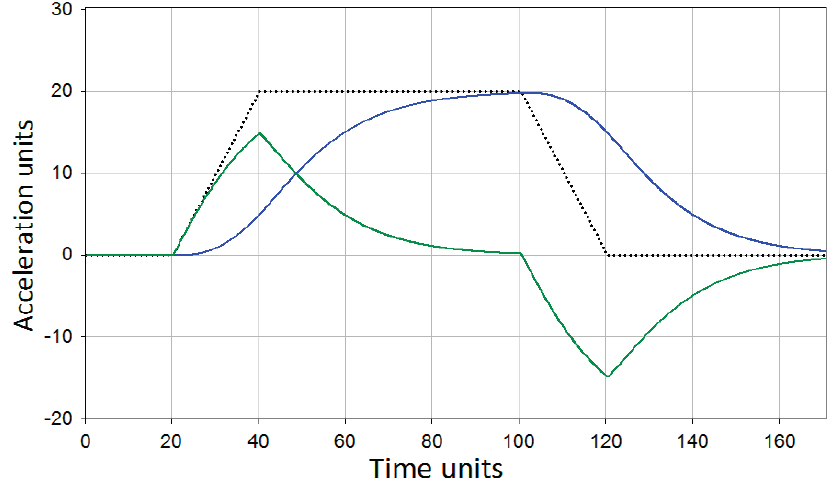
Figure 2. Time-domain simulation of the signal summation. Signal passed through the filter (2)—green line, signal passed through the filter (3)—blue line. Resulting signal—black dotted